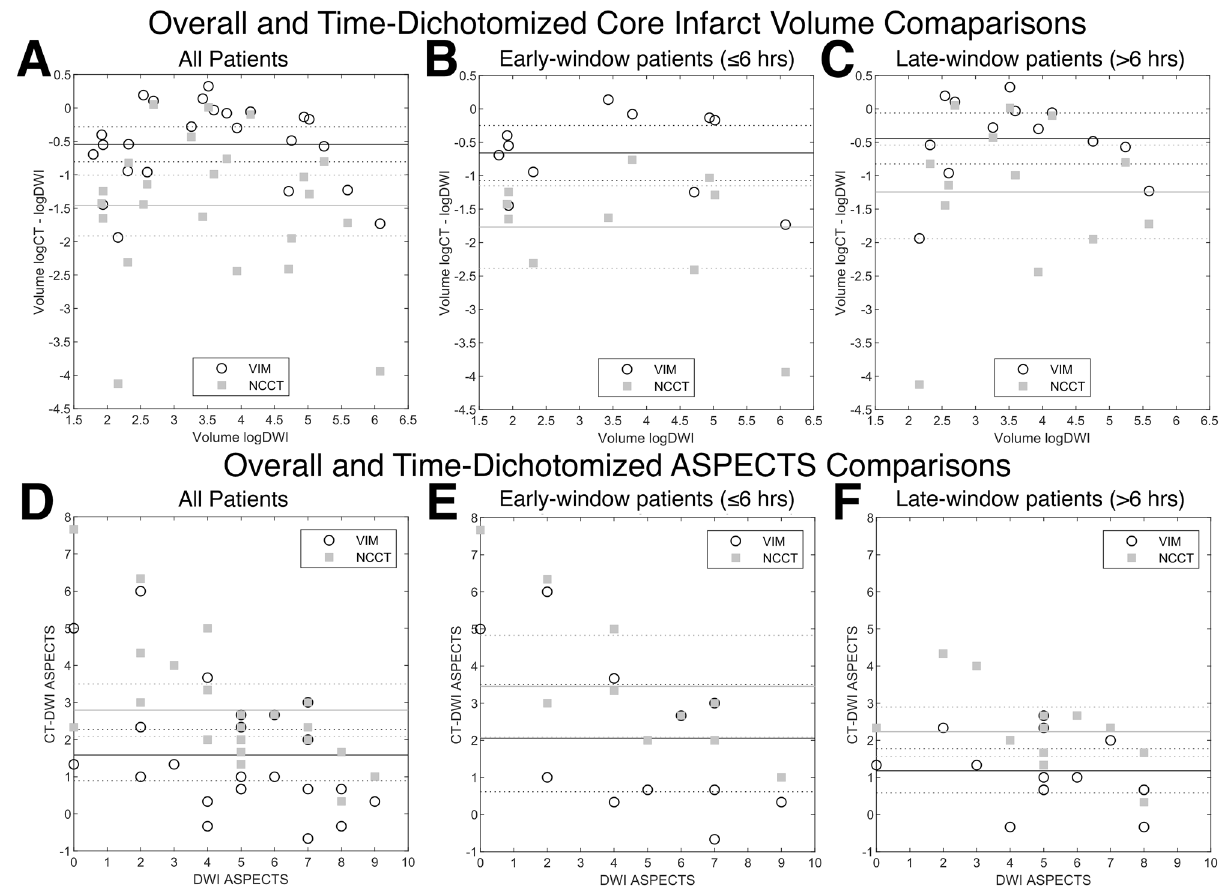
Figure 2. Overall and time-dichotomized Bland–Altman analyses of ischemic core volume and ASPECTS agreement. ( A – C ) Modified Bland–Altman analyses of ischemic core volumes are presented relative to reference standard DWI infarct volumes. In order to correct for a non-Gaussian distribution of volume data, logarithmically corrected VIM and NCCT volumes minus the logarithmically corrected DWI volumes are plotted against the logarithmically corrected DWI volumes for all patients ( A ), and for patients in the early- ( B ) and late-windows ( C ). Please refer to Supplemental Figure 2 for non-logarithmically corrected plots. ( D – F ) Modified Bland–Altman analyses of CT-ASPECTS are presented as the difference between VIM- or NCCT- ASPECTS and the corresponding consensus DWI-ASPECTS for all patients ( D ), and for patients in the early- ( E ) and late-windows ( F ). Solid lines indicate the mean bias value for each measurement, and hashed lines indicate the 95% agreement interval limits. Values closer to 0.0 indicate greater agreement with the reference DWI volume for ( A – C ), or greater agreement with the consensus DWI-ASPECTS for ( D – F ). Data were processed in SPSS 25.0 (IBM, Armonk, NY) and Matlab R2020b (Mathworks, Natick, MA), with the latter software used for graph